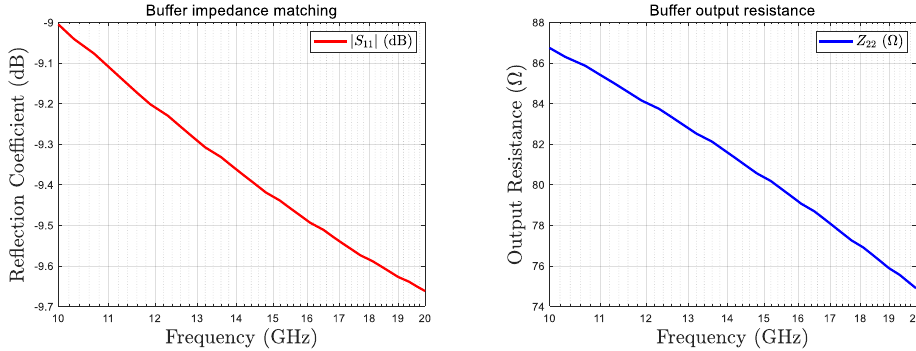
Figure 9. Simulated buffer output impedance matching ( left ) and output resistance ( right ) .